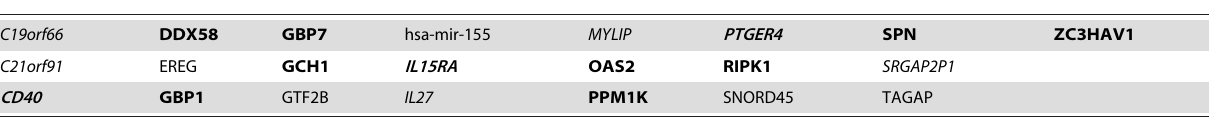
Table 5. Additional genes considered in the network-based